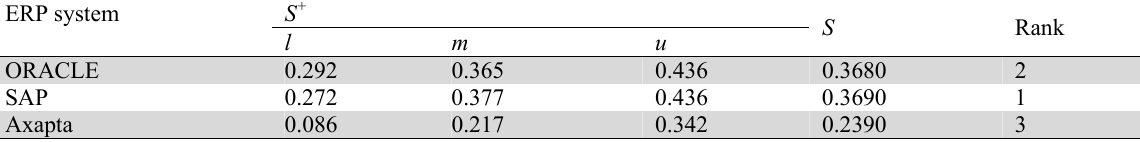
Ranking of ERP systems for example